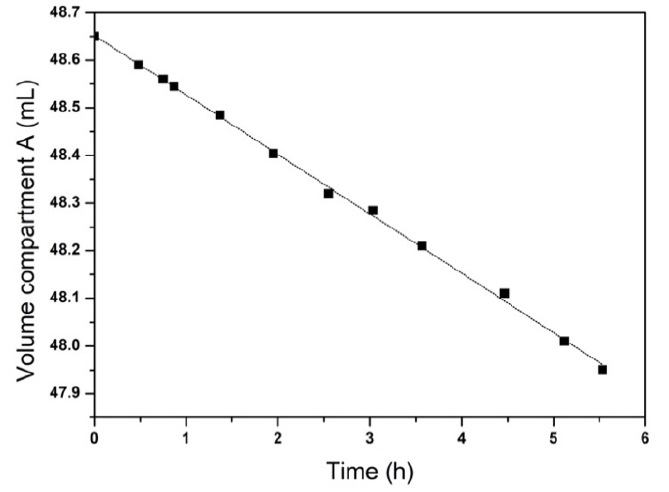
Figure 4. Volume of water over time in compartment A of the diffusion cell in Figure 3a. Volume measurement error <1%.